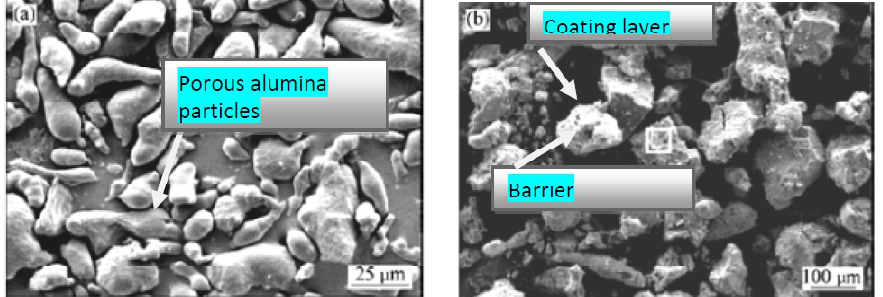
Fig. 5. SEM images of aluminium particles: (a) before coating (b) after coating. Reprinted with permission from B. Abbasipour, B. Niroumand, S. M. Monir Vaghefi // Trans. Nonferrous Met. Soc China 20 (2010) 1561, Copyright © 2010.